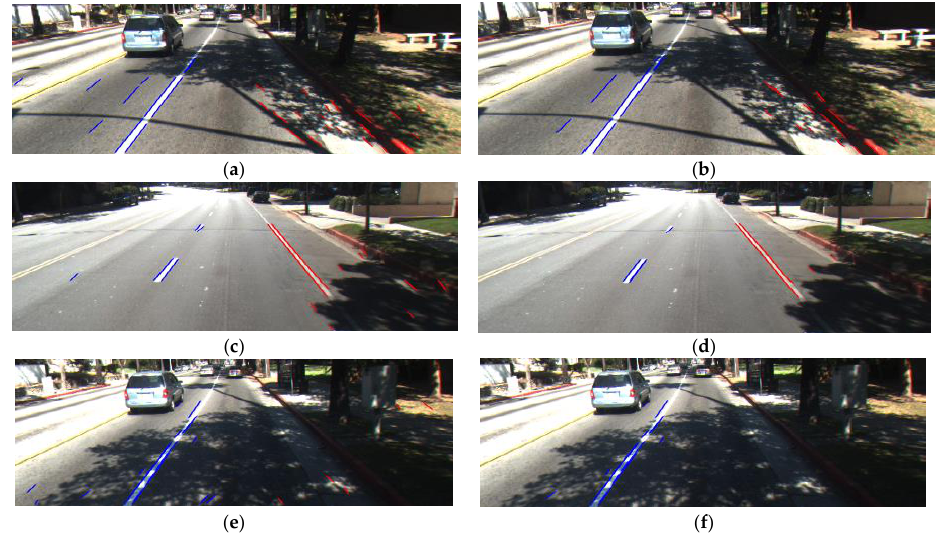
Figure 15. Remove irrelevant line segments based on the vanishing point condition: ( a , c , e ) Before using the vanishing point condition; ( b , d , f ) After using the vanishing point condition.